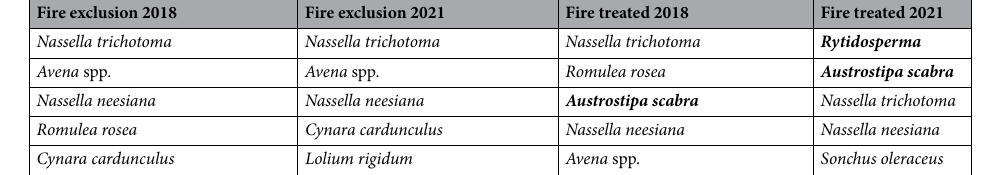
Table 6. The most abundant five species surveyed in the first and fifth sampling periods for the fire treated and fire excluded plots. The native species are highlighted in bold font.